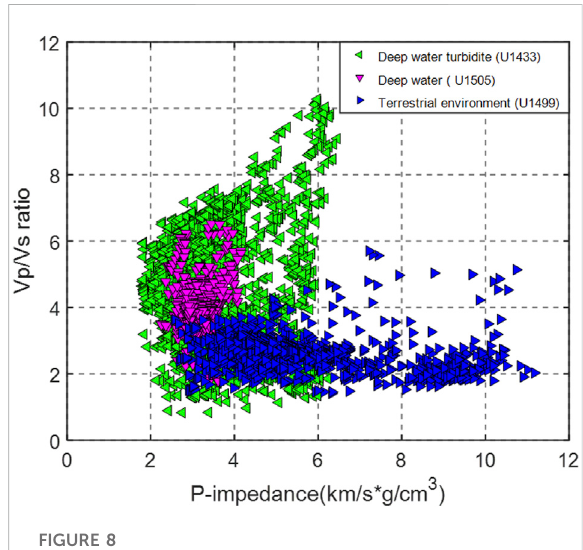
Cross plot of P-impedance versus Vp/Vs ratio for IODP logging data of sites U1505C, U1499, and U1433. Data points are color-coded by different depositional